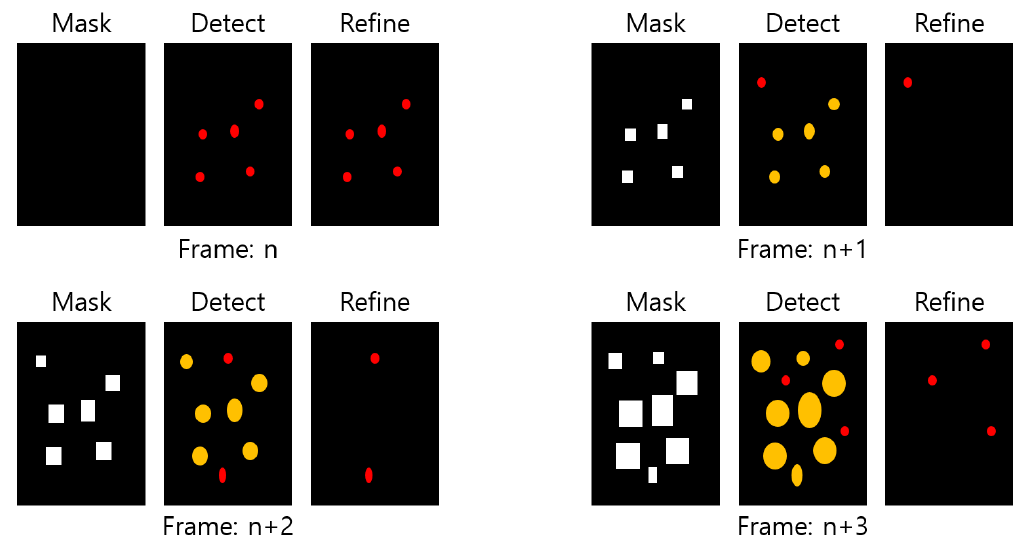
Figure 10. An illustration of detecting the first penetrating fragments using the mask-based temporal filtering